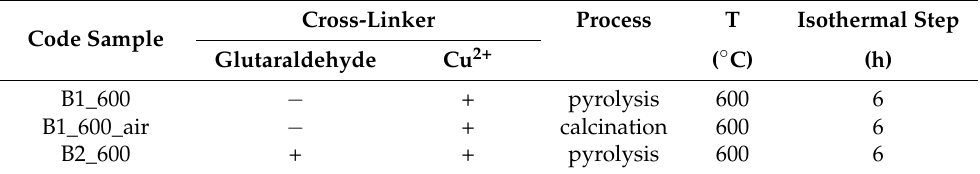
Table 1. Various protocols of calcination and pyrolytic/sintering treatment of beads. Code Sample